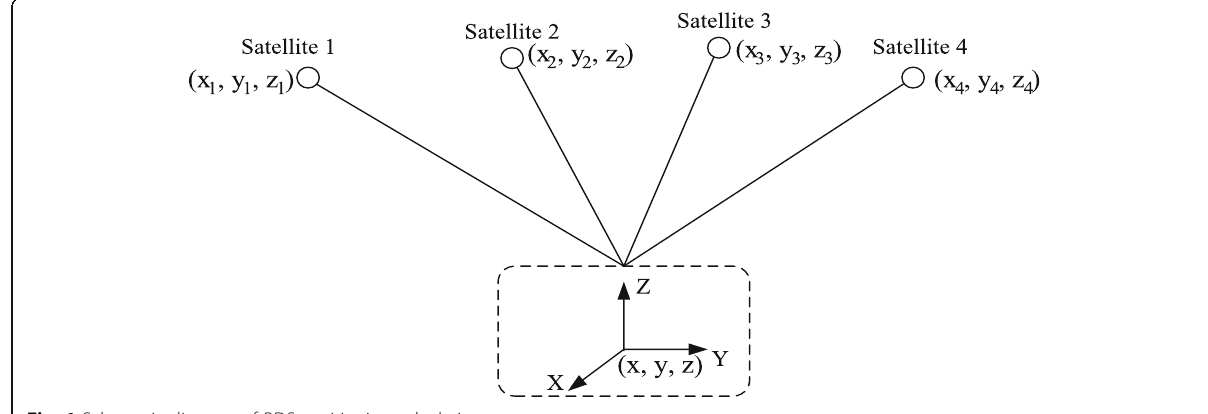
Fig. 1 Schematic diagram of BDS positioning